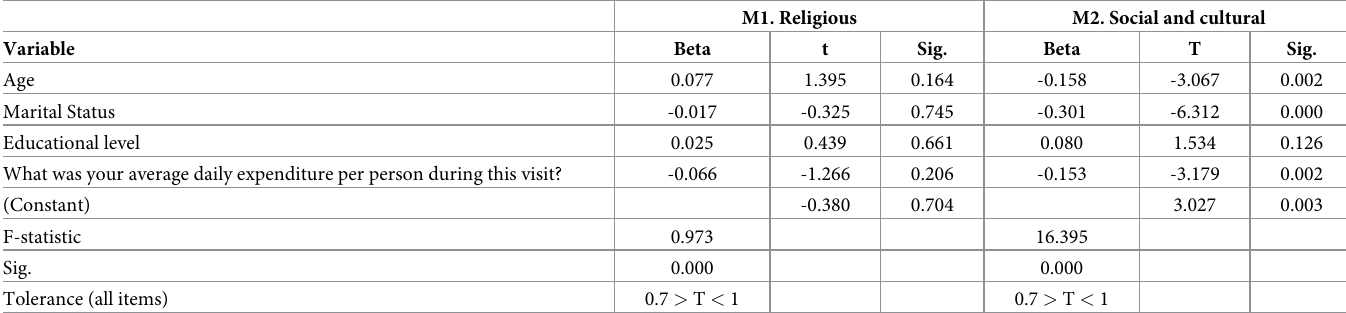
Table 2. Socio-demographic variables and religious, social, and cultural motivations.